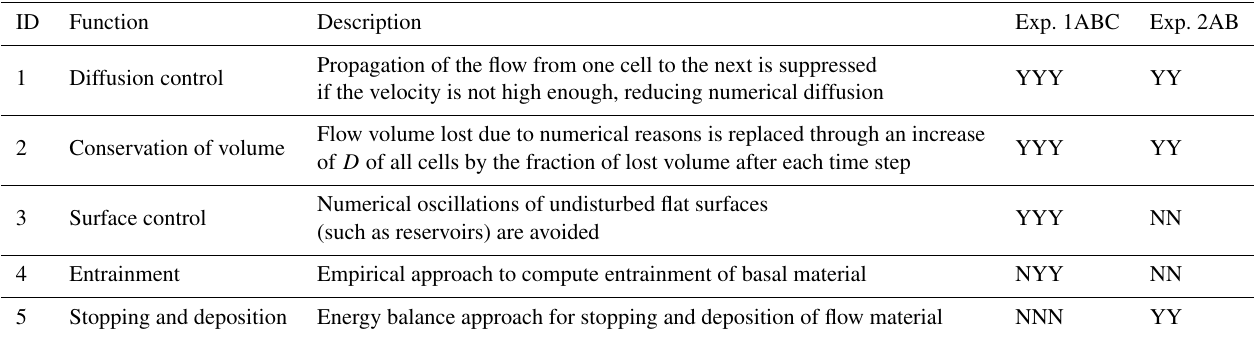
Table 3. Functionalities of r.avaflow introduced for numerical purposes (ID 1–3) or complementing the Pudasaini (2012) model (ID